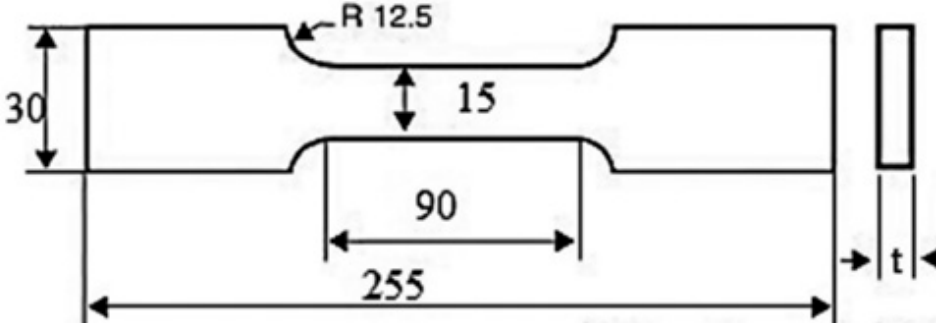
Figure 3. Geometry of tensile test specimens.